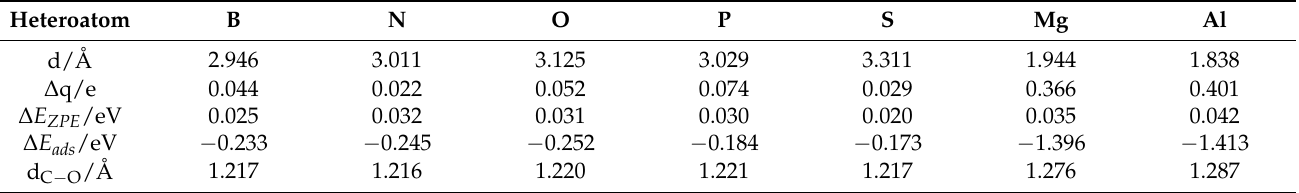
Figure 2. Top and side views of the lowest energy adsorption configurations for HCHO molecules on ( a – g ) B-, N-, O-, P-, S-, Mg-, and Al-doped graphene substrates. The red and white ball represents O and H atoms, respectively. Heterochromatic atoms embedded in graphene represent the heteroatom dopants. Table 1. For the HCHO molecule adsorbed on XG (X = B, N, O, P, S, Mg, and Al) surfaces, the nearest distances between heteroatom X and the HCHO molecule, charge gains of the adsorbed HCHO molecule, zero-point energy corrections of the HCHO molecule, and adsorption energies and C–O bond length of the adsorbed molecule are presented.